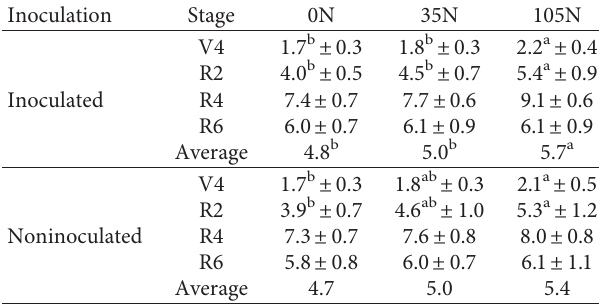
Table 8: The effect of different fertilization rates on LAI at different stages of soybean’s (cv. Bogl´ar) life cycle, averaged among 2017, 2018, and 2019 in Debrecen,